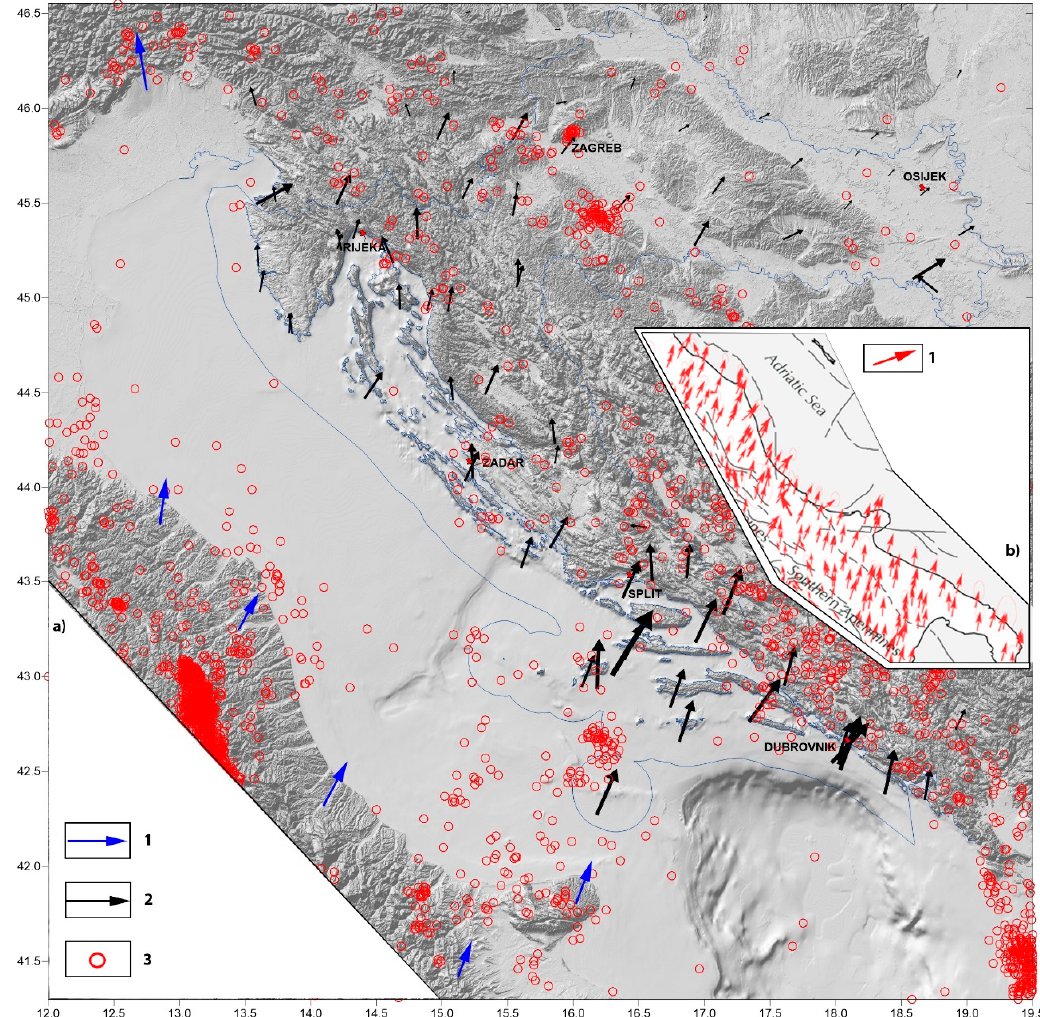
Figure 6. ( a ) Velocity vectors directions on geodetic points in Croatia, averaged velocity vector directions on geodetic points in Italy and seismic activity from 2004 to 2021. Legend: 1—annual velocity directions on geodetic points in Croatia; 2—averaged velocity directions on geodetic points in Italy; 3—earthquake epicentres in the period 2004—2021 with M > 3. (EMSC). ( b ) velocity directions on geodetic points in Italy—part (from [3]).